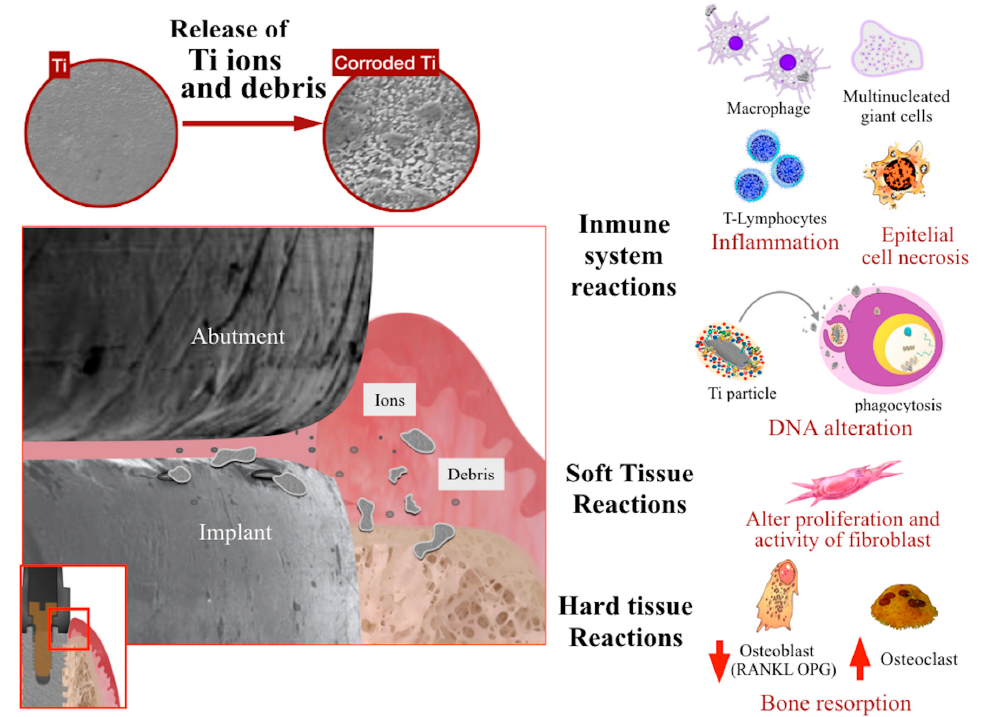
Figure 2. Release of Ti ions and the biological reactions. Adapted from Apaza–bedoya et al. 2017 [5]. Titanium ions and particles induce cytotoxic effects depending on the size and concentration surrounding the cells [4,11,12,70–72]. Previous studies suggested that stimulation of the proinflammatory response is caused by submicron- and micro-scale particles [10,73]. Thus, the contact area of micro-scale particles is higher than on titanium macro-scale particles, which increase the dissolution of the titanium oxide thin film [73] while submicron-scale particles can be engulfed by the cells. Over 11 ppm, Ti ions showed to be cytotoxic, since they stimulate monocyte migration and may modulate the sensitivity of gingival epithelial cells to oral bacteria via toll-like receptors [74]. Other studies reported that a solution with 5 ppm Ti ions and Porphyromonas gingivalis -Lipopolysacaride- induced monocytes infiltration in the gingival and bone tissues via CCL2 cytokines [74,75]. Nevertheless, titanium ions might decrease bacterial growth due to their toxicity also on bacterial cells. In fact, a high concentration of Ti ions at 500 ppm can also decrease the microbial cell viability [18].